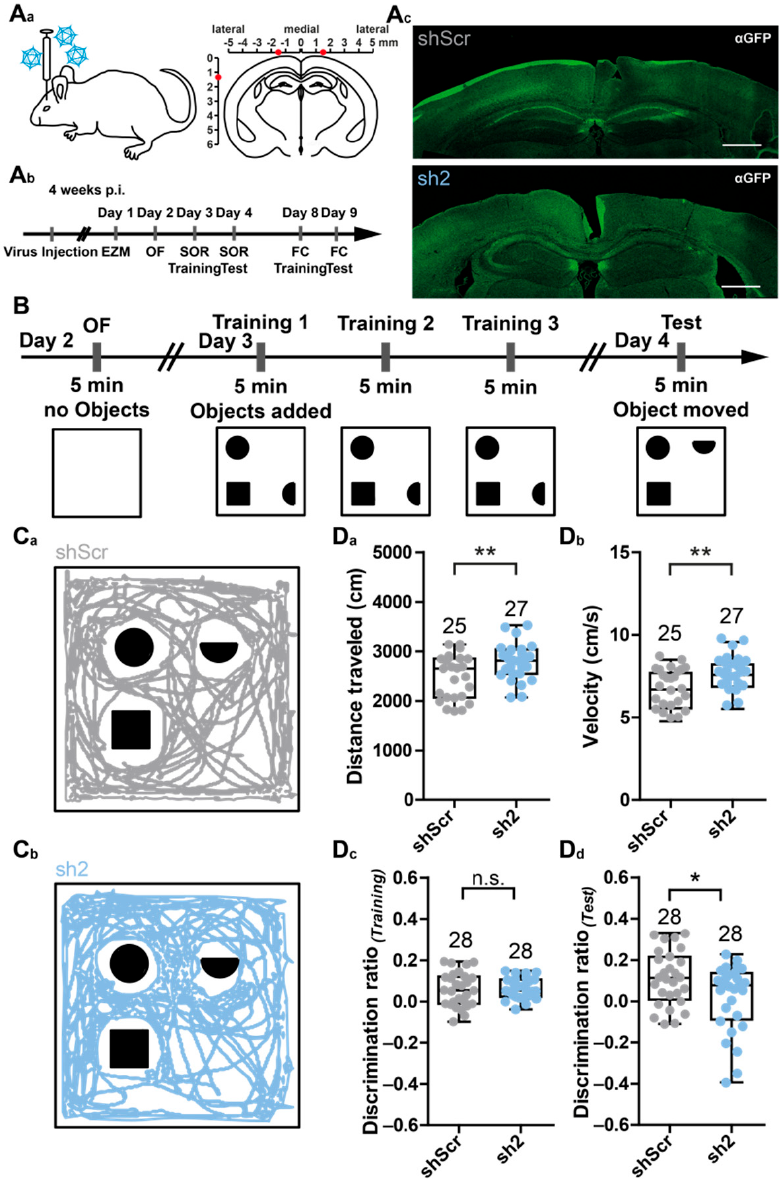
Figure 3. Stereotaxic injection of rAAVs into the dorsal hippocampus and effects of HCN2 loss on spatial object recognition (SOR). ( A ) Injection of rAAVs into hippocampi of mice. ( A a ) Schematic showing bilateral injections of rAAV9 virions coding for shScr or sh2 into the dorsal hippocampi of mice. ( A b ) Timeline of stereotaxic injections and behavioral experiments (EZM, elevated zero maze test; OF, open field test; SOR, spatial object recognition test; FC, fear conditioning test). ( A c ) Representative immunofluorescent images showing expression of the eGFP-reporter (green) in rAAV9-shScr (control, upper panel) or rAAV9-sh2 (HCN2 knock-down, lower panel) bilaterally injected hippocampi. Scale bar 500 µm. ( B ) Schematic showing the timeline and arena settings of the SOR test. ( C ) Tracks of mice bilaterally injected with ( C a ) rAAV9-shScr (gray) or ( C b ) rAAV9-sh2 (blue) are shown for the testing session. ( D ) Analysis of the behavior of injected mice during SOR testing. Analysis included ( D a ) distance traveled during testing session, ( D b ) velocity of movement during testing session, ( D c ) discrimination ratio between displaced and non-displaced objects during training session, and ( D d ) discrimination ratio between displaced and non-displaced objects during testing session. Data are depicted as boxplots. Numbers above boxplots indicate the number of tested animals. Statistical significance was assessed using the unpaired two-tailed Student’s t -test, * p < 0.05; ** p < 0.01.